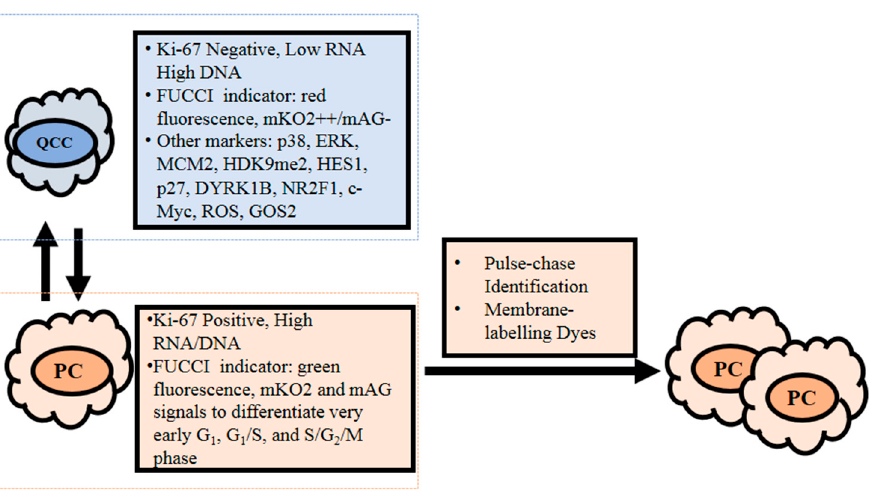
Figure 3. Current detection methodology for quiescent cancer cells (QCCs) that reside at G 0 phase. QCCs are generally detected based on their Ki-67 negative and low cellular RNA content, while proliferating cells are Ki-67 positive and contain high RNA and DNA. Other detection methods are also applied to assist in differentiating between quiescent and proliferating cells. With a fluorescence ubiquitin cell cycle indicator (FUCCI), G 0 /G 1 cells are labeled with red fluorescence or identified based on their mKO2 ++ /mAG - signal. Proliferating cells are identifiable by FUCCI as green fluorescence and further distinguished via mKO2 and mAG signals: G 1 (mKO2 + /mAG - ), very early G 1 (mKO2 - /mAG - ), G 1 /S (mKO2 + /mAG + ), and S/G 2 /M (mKO2 - /mAG + ) phases. Other potential molecular markers for QCCs are p38 high /ERK low , MCM2 low /H3K9me2 low /HES1 high ; high levels of p27, dual specificity tyrosine phosphorylation-regulated kinase 1B (DYRK1B), nuclear receptor subfamily 2 group F member 1 (NR2F1), and G 0 /G 1 switch gene 2 (GOS2); and low levels of c-Myc and reactive oxygen species (ROS). Pulse-chase identification and membrane-labeling dye methods involve dilution of respective fluorescent and membrane-labeling dyes as cells proliferate. Hence, label-retaining cells are slow cycling cells, while label-diluted cells are proliferating cells.